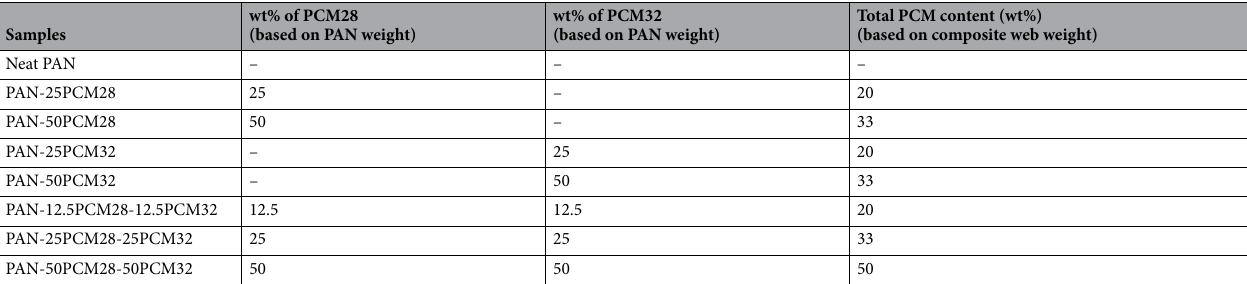
Table 2. Compositions of the PAN/PCM nanofiber mats